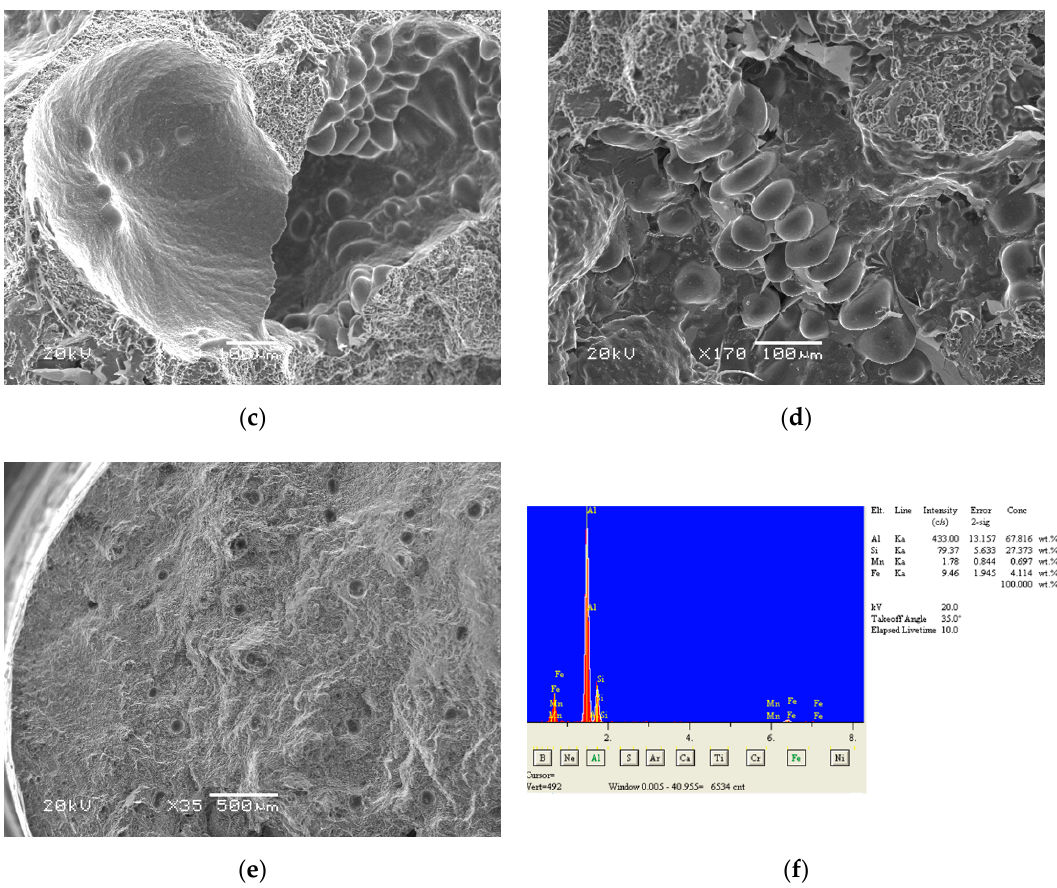
Figure 7. SEM images of tensile test bar fracture surfaces. ( a ) Source D with pores, ( b ) Source D with crumples oxides (bifilm) inside the pores. ( c ) Source D with large oxides and pores ( d ) Source D with plate-like β -iron intermetallic. ( e ) Source C with fine and distributed pores. (f) EDS (Energy Dispersive X-Ray Spectroscopy) analysis of arrows marked in “d”.